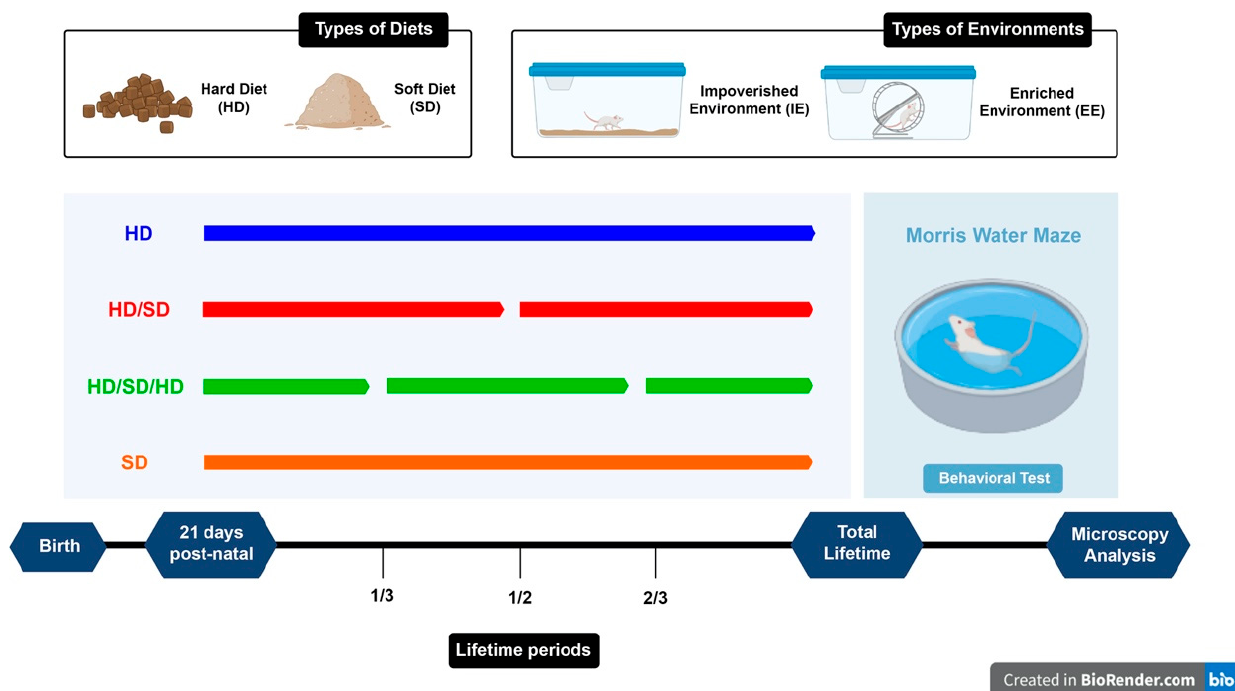
Figure 1. Experimental timeline. Female Swiss albino mice were fed under one of the following diet regimens: continuous hard (pellet) (HD), continuous soft (powder) diets (SD), sequences of hard and soft diet (HD/SD), as well as series of hard, soft, and hard diets (HD/SD/HD). Mice were maintained either in standard or enriched cages from 21st postnatal day onwards. Continuous or interrupted colored lines indicate continuous or interrupted diet regimens respectively: blue, red, green, and orange lines indicate HD, HD/SD, HD/SD/HD, and SD diet regimens respectively. The Morris water maze (MWM) behavioral tests are schematically represented on the right side of the scheme. Graphic representation of soft and hard diets, as well as standard and enriched cages are on the top.